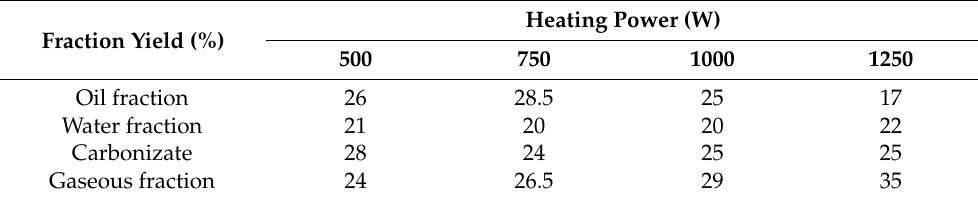
Table 8. The efficiency of individual fractions depending on the power of microwave heating. Fraction Yield